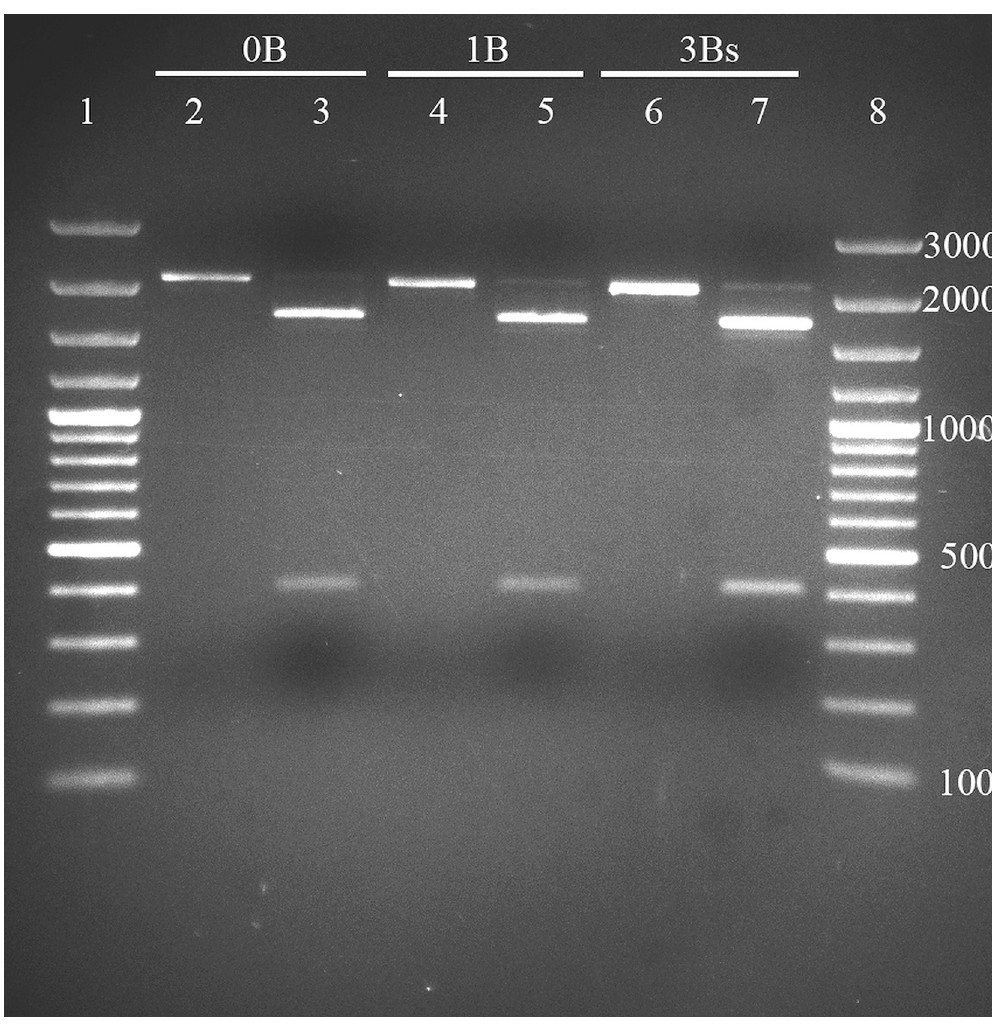
Fig 3. RFLP results of mixed digestion of 2200 bp DNA band with Sac I and Hae III. Lines 2, 4, 6 — extracted and purified 2200 bp DNA bands without digestion; lines 3, 5, 7 — digested 2200 bp bands; lines 1, 8- GeneRuler 100 bp DNA Ladder Plus, Thermo